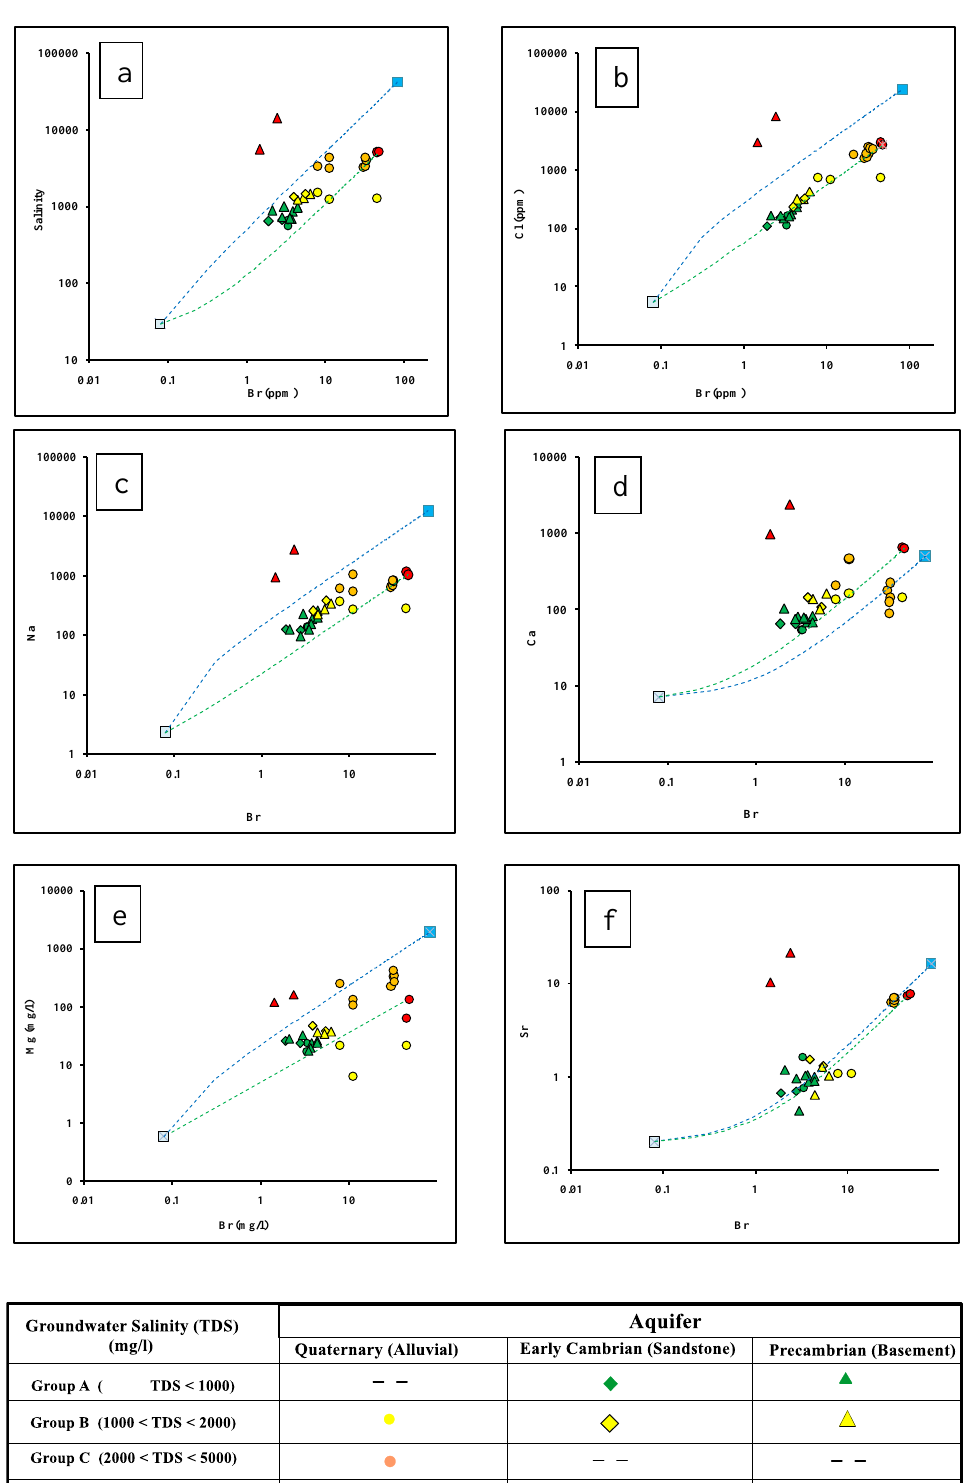
Figure 4. Logarithmic diagrams of ion relationships in groundwater of the Dahab watershed. The logarithmic plots of ( a ) Total dissolved solids ( b – e ) concentrations of major ions and ( f ) Sr versus Bromide.